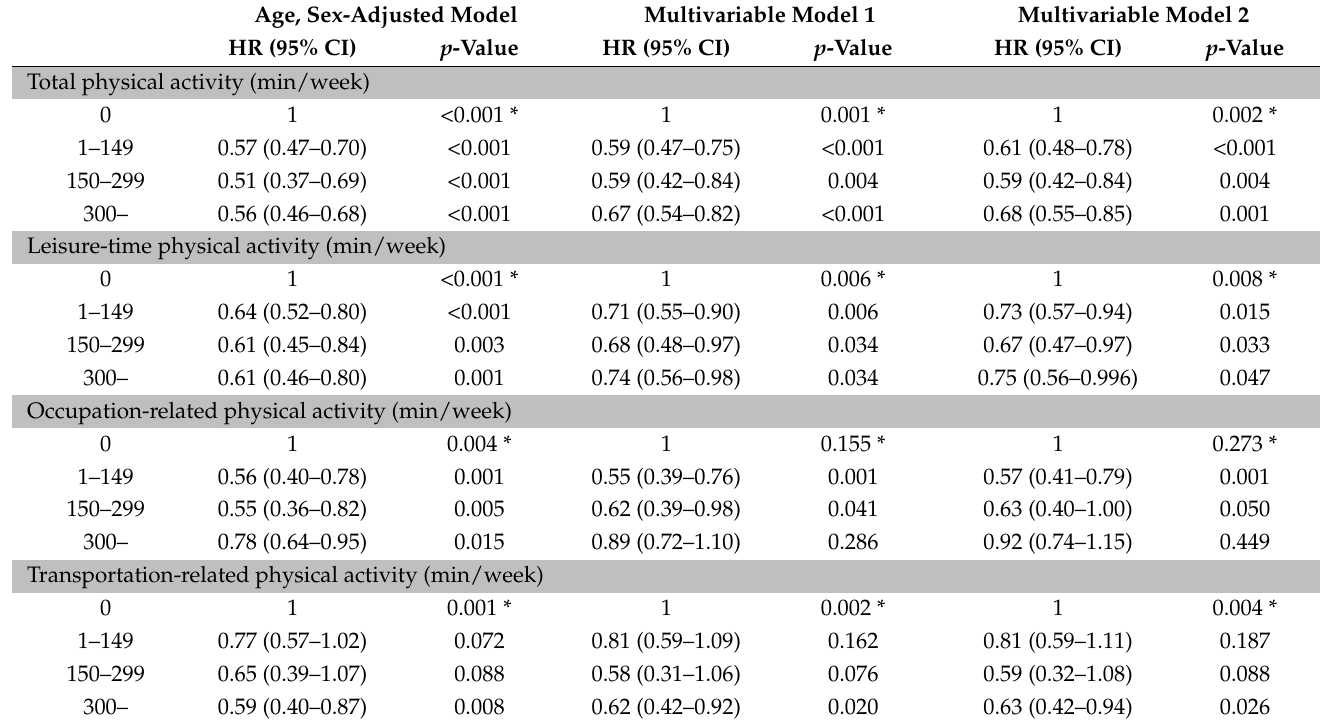
Table 3. Multivariable Hazard Ratio for All-Cause Mortality based on the Amount of Physical Activity among Individuals with NAFLD as defined by the Hepatic Steatosis